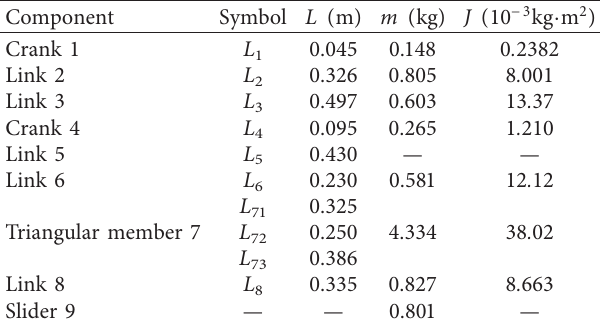
Table 1: Geometric and inertial parameters.